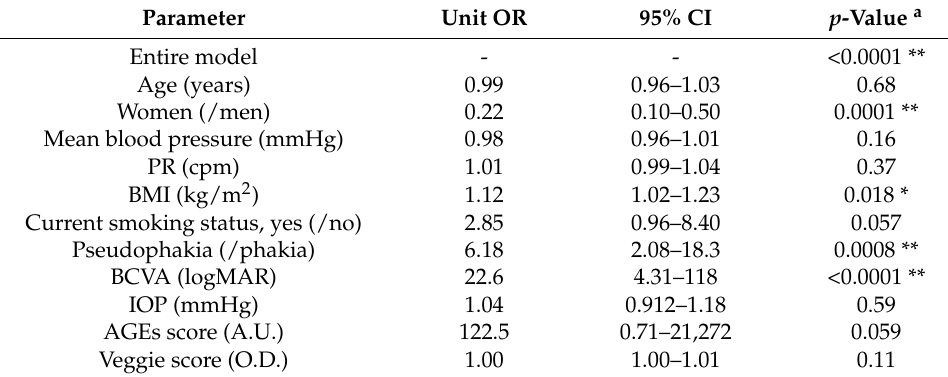
Table 2. Multivariate logistic regression analysis for risk factors for DM.